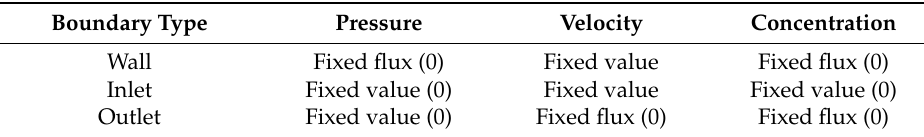
Table 1. Boundary conditions used in our numerical